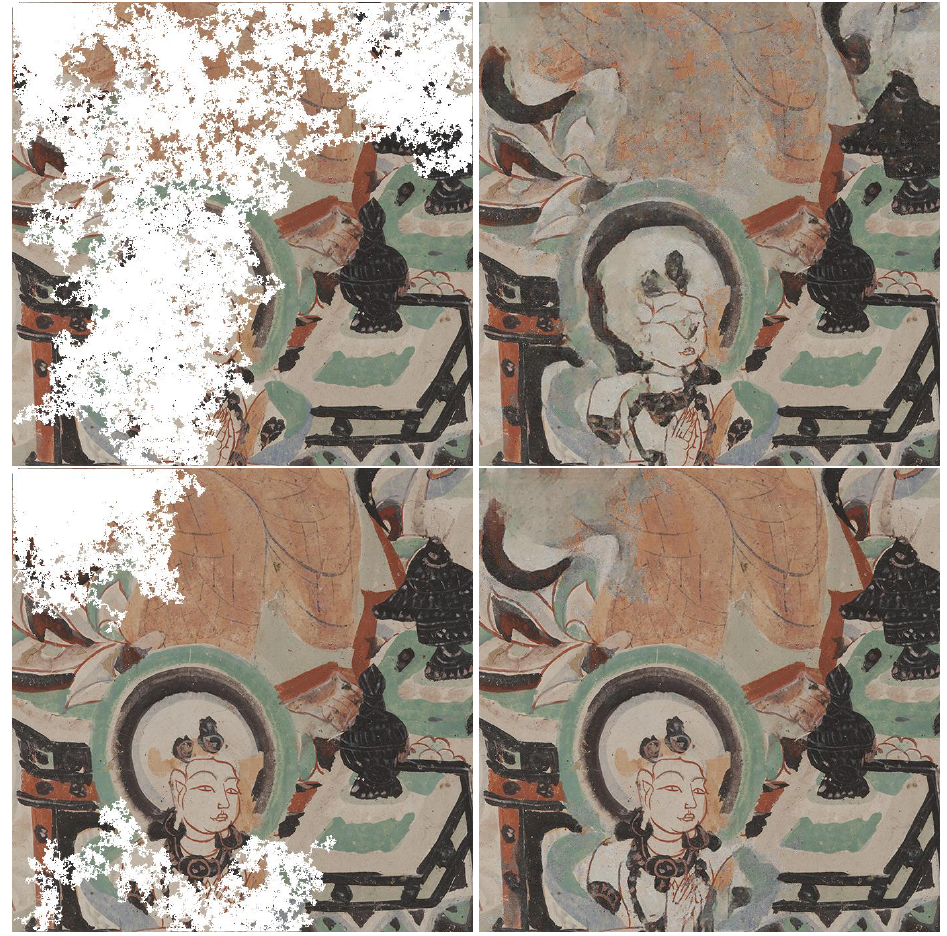
Figure 7. Inpainting results for random walk deterioration with different coverage of the same scene (ground-truth is Figure 6a). The inpainted images were generated at full resolution, however they are shrinked for display purposes here. Even though, in the first deteriorated example, the face of the character is mostly covered, the inpainted version manages to reconstruct some structural details with good accuracy, such as the aura, the lips and the left